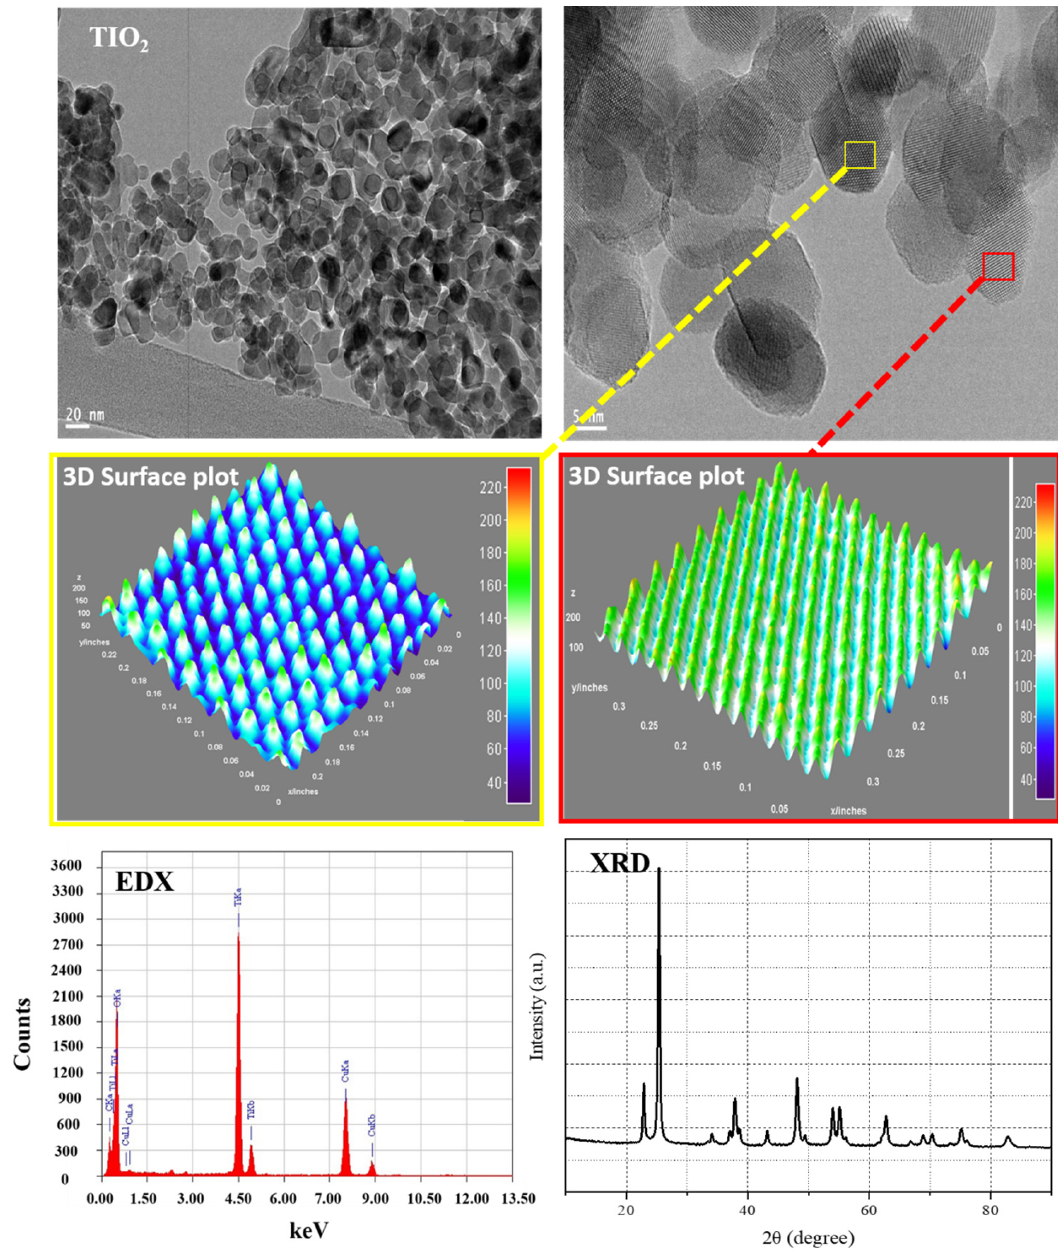
Figure 2. TEM, 3D surface plot, EDX and XRD of the synthesized TiO 2 NPs.